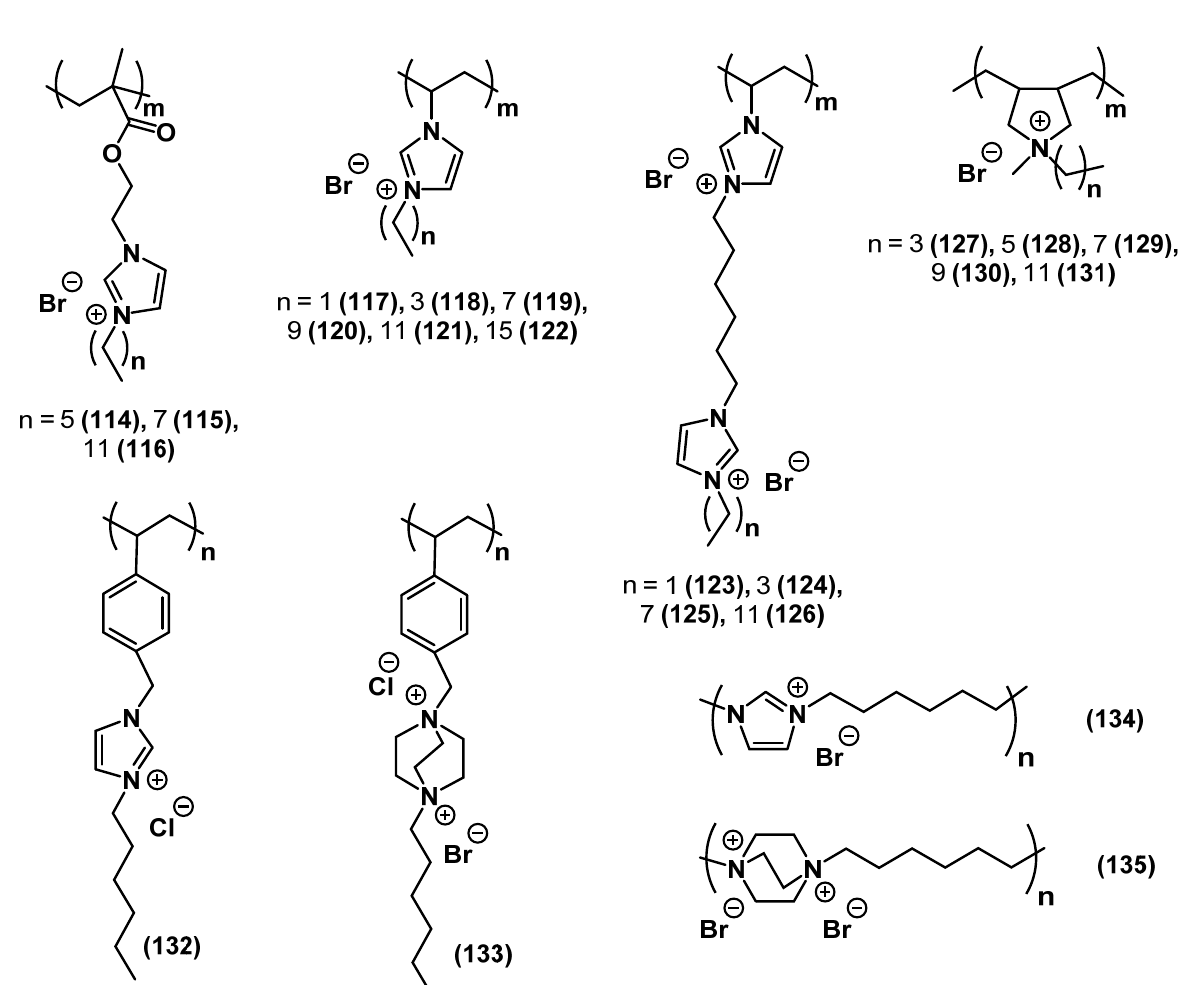
Figure 35. Examples of poly-ILs with tested antimicrobial activity. The numbers of substances correspond to those in Table 8. Table 8. Antimicrobial activity of poly-ILs * .